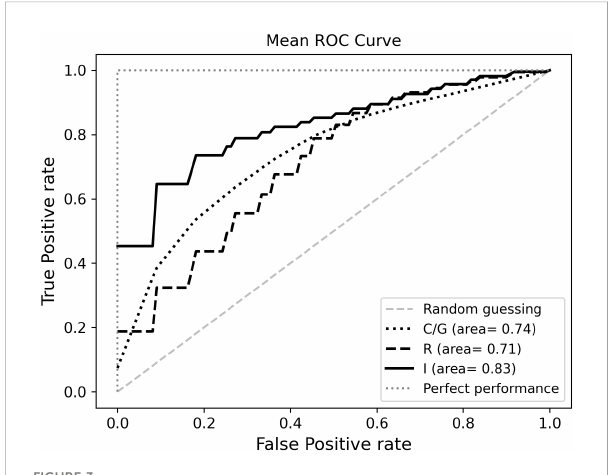
FIGURE 3 Mean receiver operating characteristic (ROC) curves.